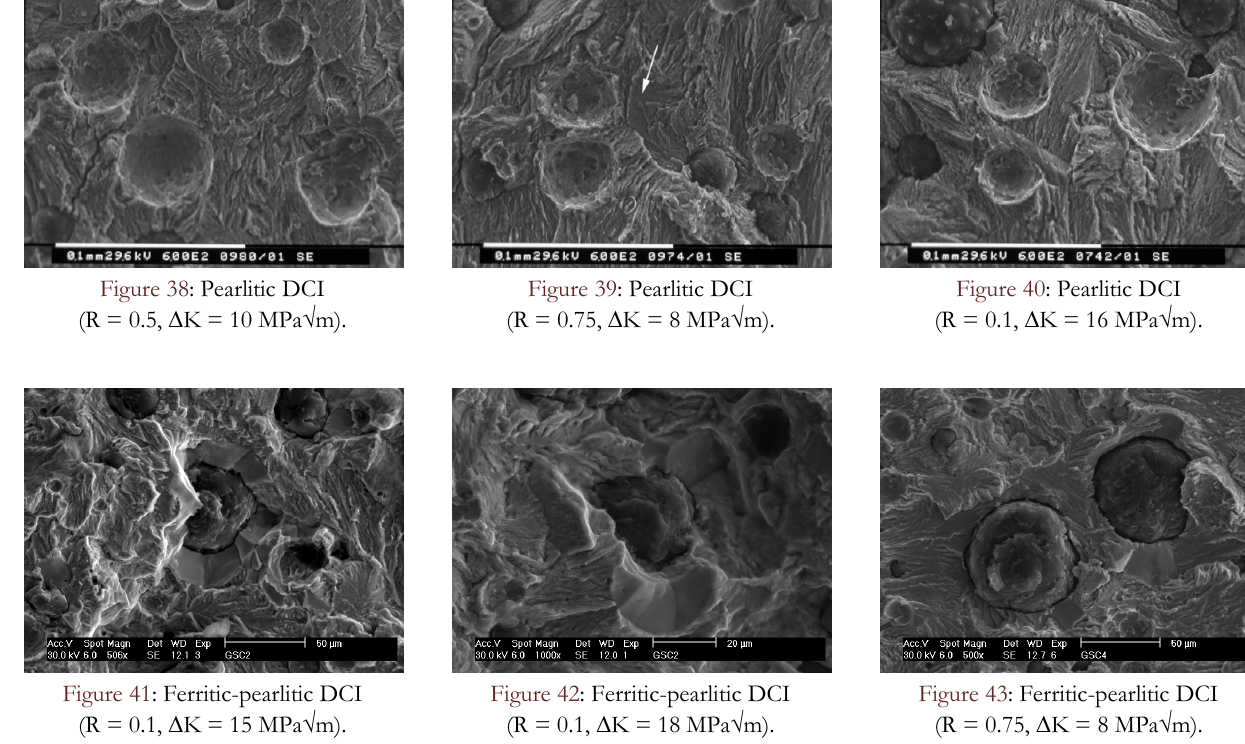
Figura 45: Ferritic-pearlitic DCI (annealed pearlitic DCI) (R = 0.75,  K = 7 MPa √ m).